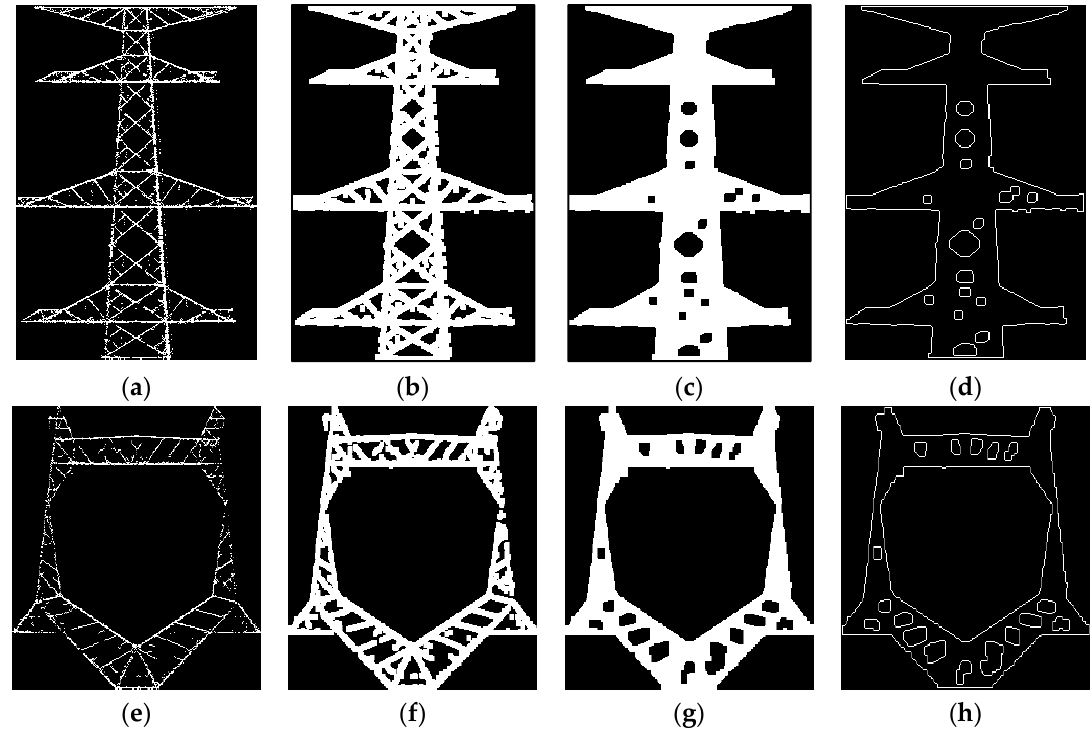
Figure 7. Image processing on point cloud above the key segmentation position: ( a,e ) The result of binarization processing; ( b,f ) the result of morphological gradient operation; ( c,g ) the result of morphological close operation; ( d,h ) the result of contours extraction.